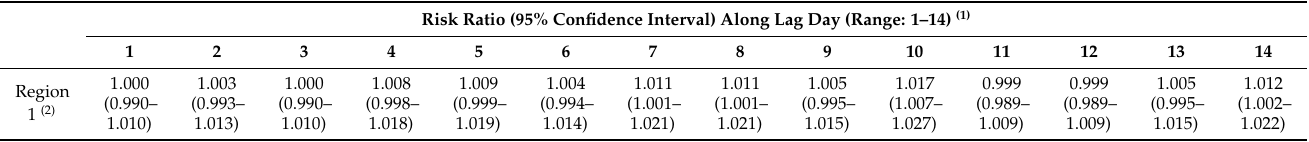
Table 2. Association between DTR and risk of diabetic foot amputation in region 1.